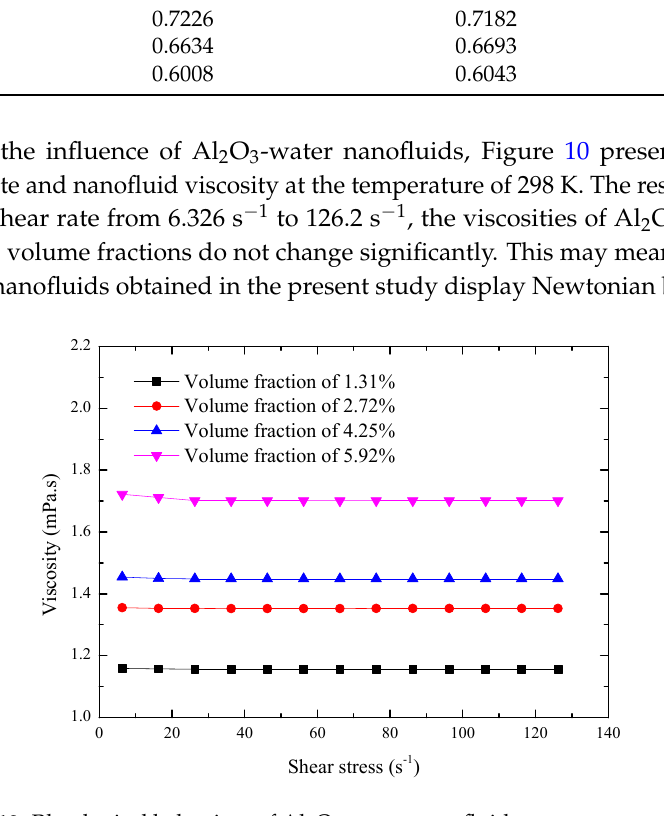
Figure 10. Rheological behaviors of Al 2 O 3 -water nanofluids at room temperature.